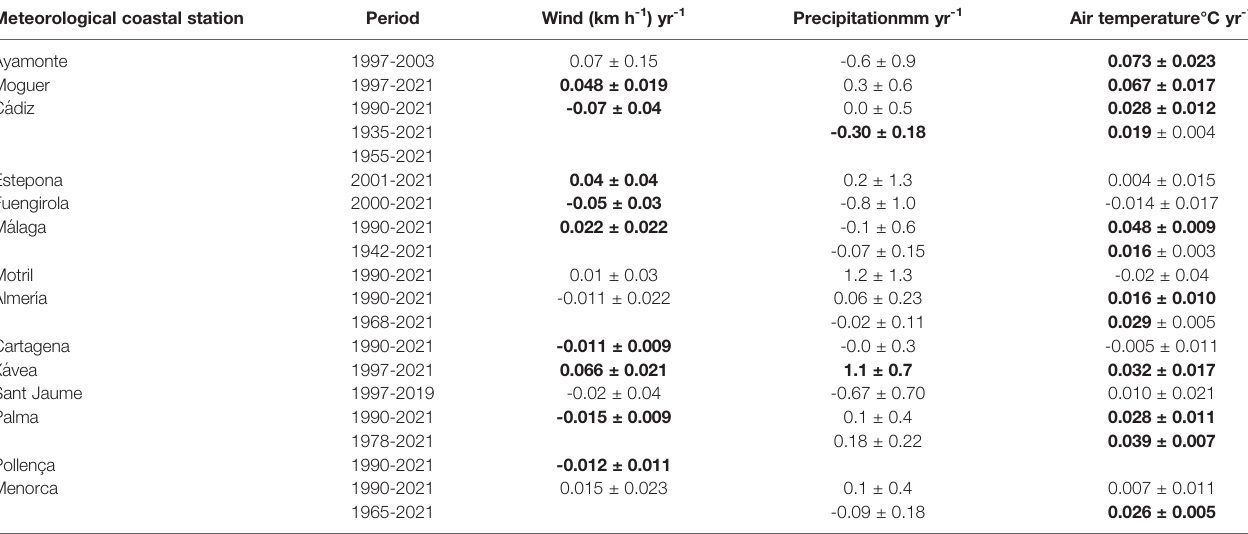
TABLE 2 | Linear trends and con fi dence interval at the 95% level (b ± CI 95%) for the wind intensity ((km h -1 ) yr -1 ), precipitation rate (mm yr -1 ) and air temperature (°C yr -1 ) at the selected coastal meteorological stations (Spanish meteorological agency, AEMET) for the longest period available. Meteorological coastal